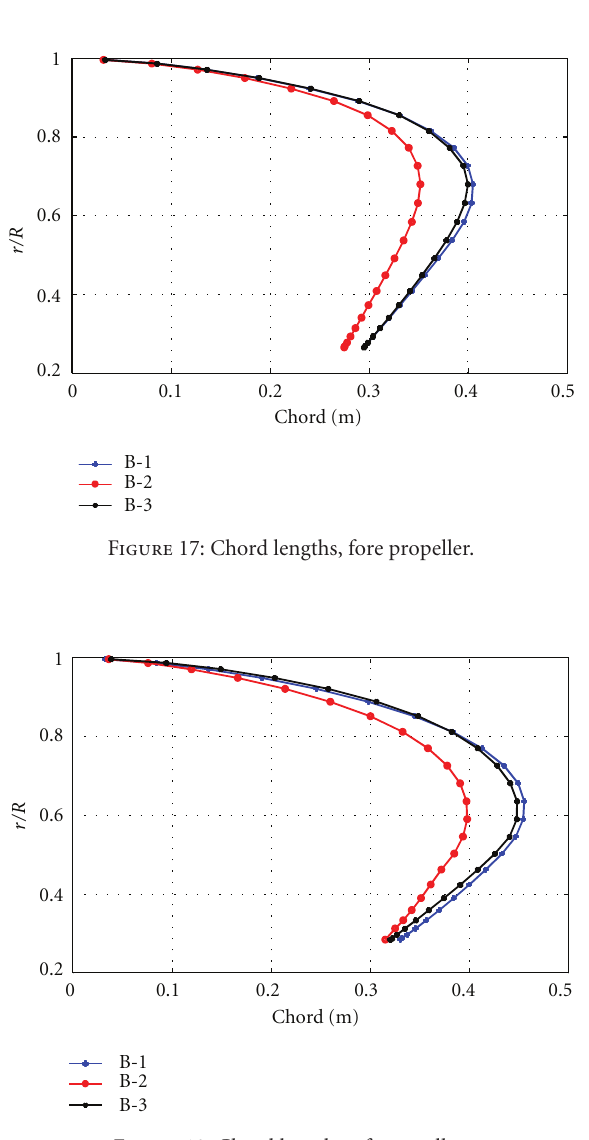
Figure 18: Chord lengths, aft propeller.